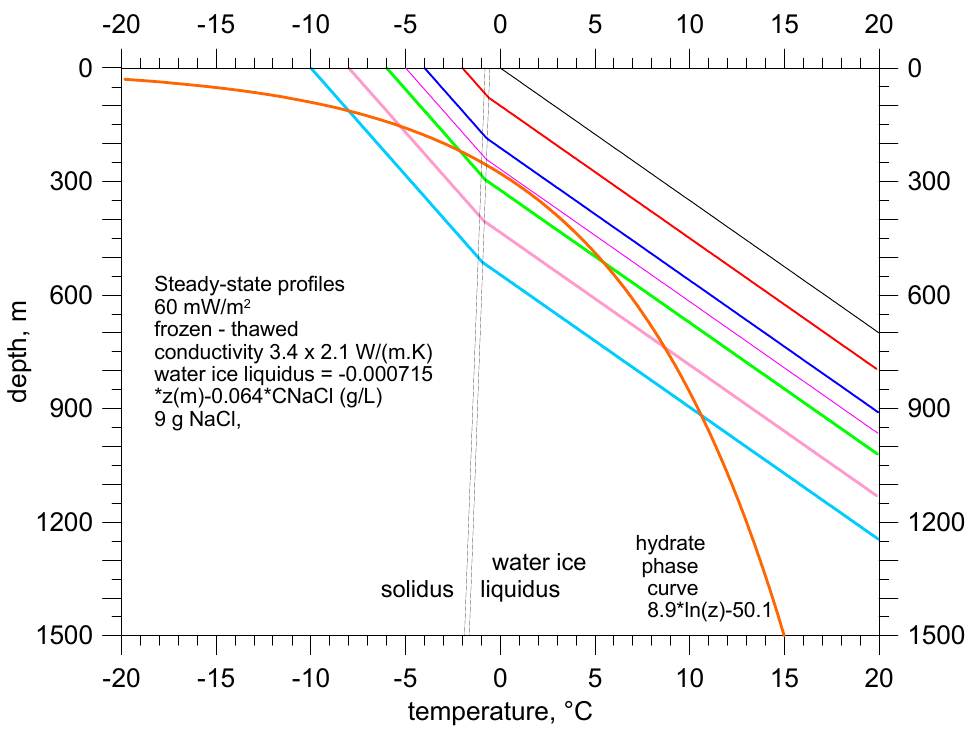
Figure 3. Steady-state profile corresponding to the best Mallik geothermal model (basal heat flow density 60 mW/m 2 , conductivity of frozen × unfrozen rock 3.4 × 2.1 W/(m·K))